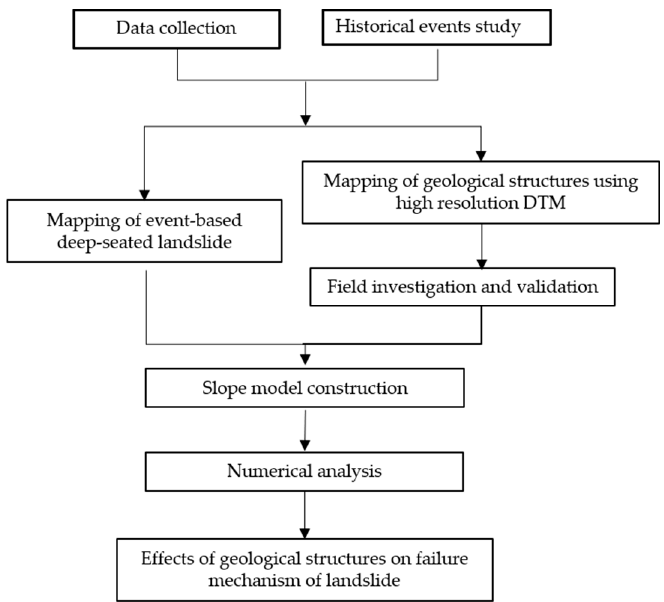
Figure 1. Methodology flowchart of this study.